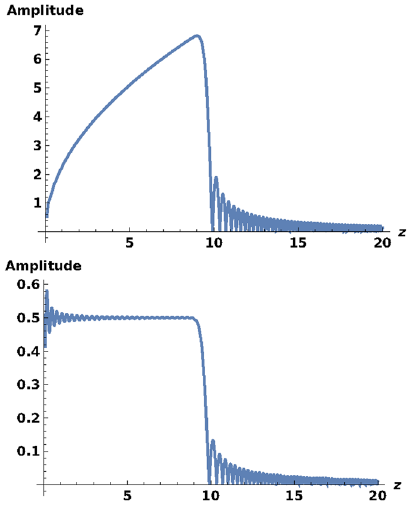
Figure 7. Axial beampattern plots for cases shown in Figure 6, (top and bottom, respectively) 5 MHz beams with distance in mm. Vertical units: arbitrary units of wave amplitude.